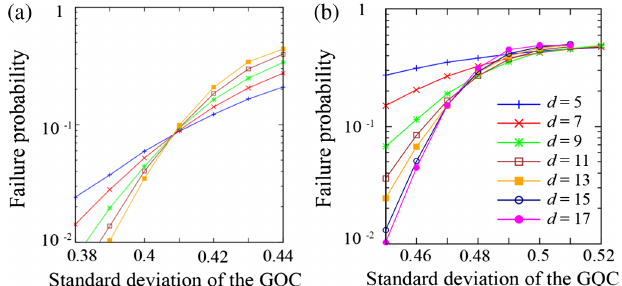
FIG. 3. Simulation results for the logical error probabilities of the surface code with noisy syndrome measurements using (a) the digital QEC and (b) the analog QEC. The simulation results for the digital QEC are obtained from 50 000 samples. The simu- lation results for the analog QEC are obtained from 10 000